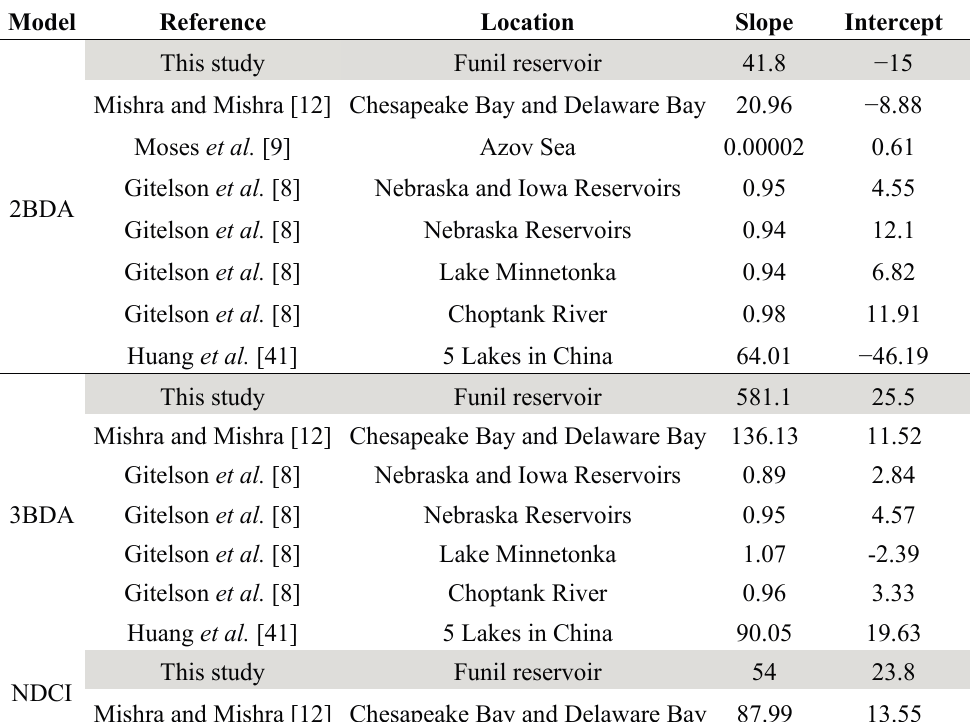
Table 10. Comparison of Slope and Intercept values from other